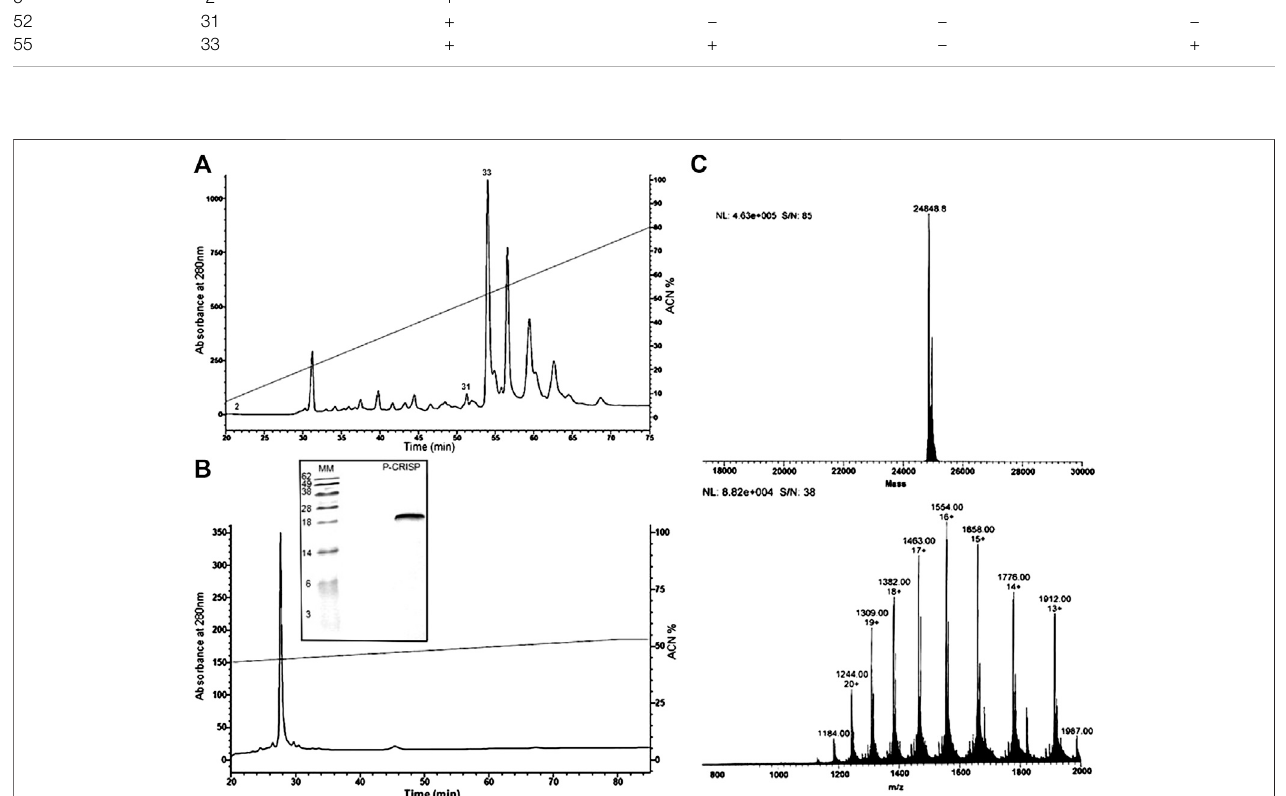
FIGURE 1 | Puri fi cation steps and molecular mass characterization. (A) Chromatographic pro fi le of Duvernoy ’ s gland secretion. Sample was subjected to a Jupiter ® C18 semipreparative column (10 μ m, 300 Å, 10 × 250 mm, Phenomenex ™ ), with a 0 – 80% linear gradient of ACN in acidi fi ed water for 80 min at 2 ml/min fl ow rate. Absorbance was monitored at 280 and 225 nm. The fractions indicated by the numbers (2, 31 and 33) had antimicrobialactivity. (B) Second step ofpuri fi cation by RP-HPLC. The chosen fraction (33) was subjected to an analytical column Jupiter ® C18 (10 μ m, 300 Å, 4.60 mm × 250, Phenomenex ™ ) to check the homogeneity. The prominent peak was hand collected and submitted to a test of the inhibition of microbial growth in a liquid medium and mass analyzing. The SDS- PAGE analysis under reducing conditions shows a single band, with a mass of 25 kDa approximately, and con fi rms the fraction homogeneity. (C) Mass spectrometry analyses. The deconvolution of the ions revealed an m/z of 24,848.8 Da. The spectrum was submitted to the MagTran ®